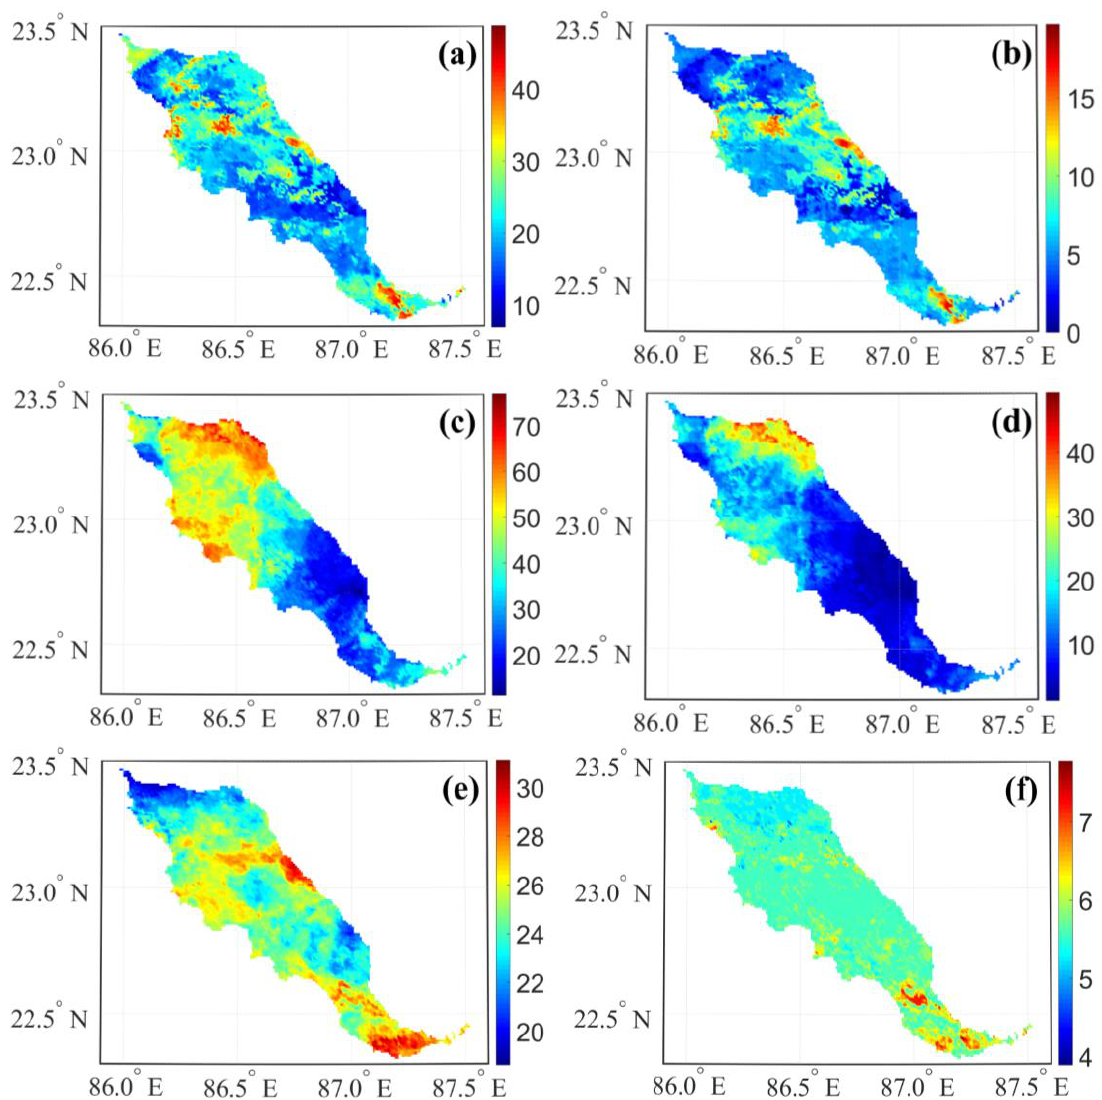
Figure 10. Drought duration maps for CMIP6 scenarios for study area KSB. (a,b) for SSP1-2.6; ( c , d ) for SSP2-4.5; ( e , f ) for SSP5-8.5. ( a , c , e ) for severe drought and ( b , d , f ) for extreme drought. The scale bar represents months of drought in 30 years (2015 – 2044).